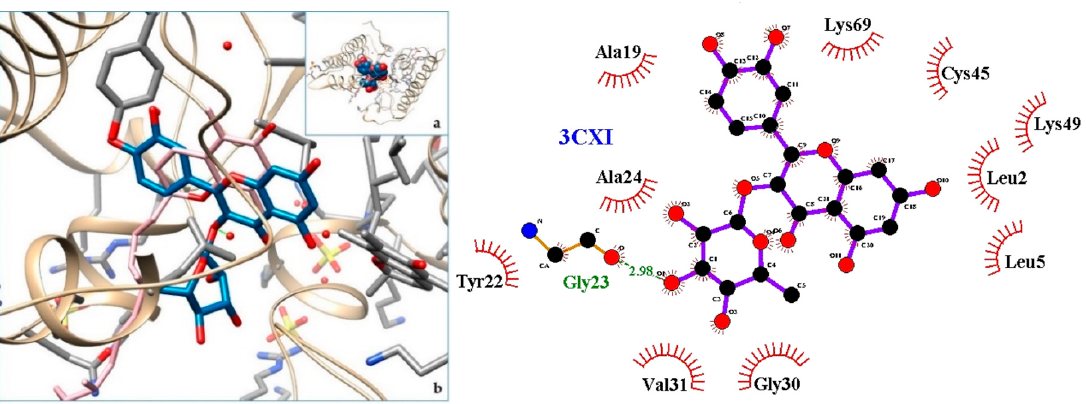
Figure 5. 3CYL quercetrin complex in the most favourable arrangement ( a ) and augmented ( b ) showing the disposition between the chain of toxins. Right: 2D interaction diagram.